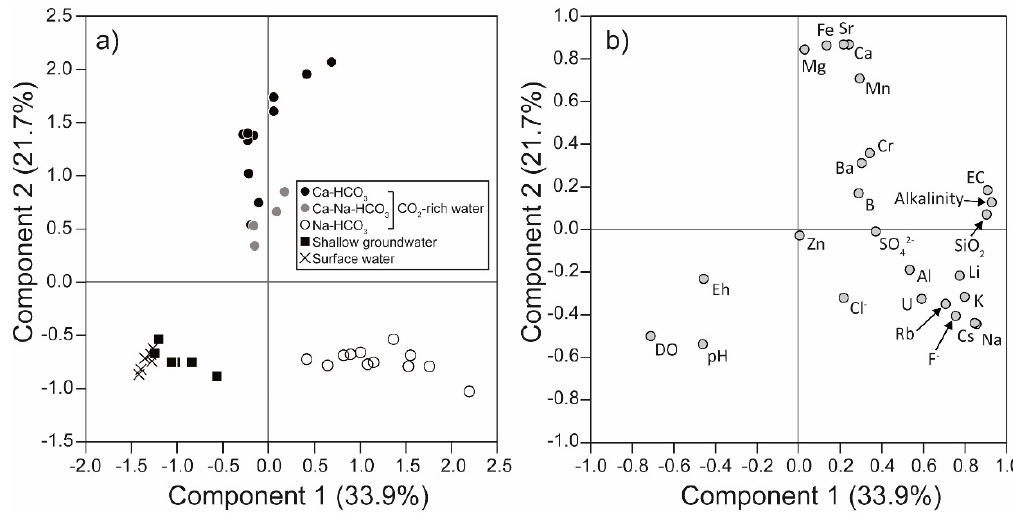
Figure 7. The first two components, 1 and 2, obtained by principal component analysis (PCA): ( a ) Scores of water samples, ( b ) Loadings of variables.